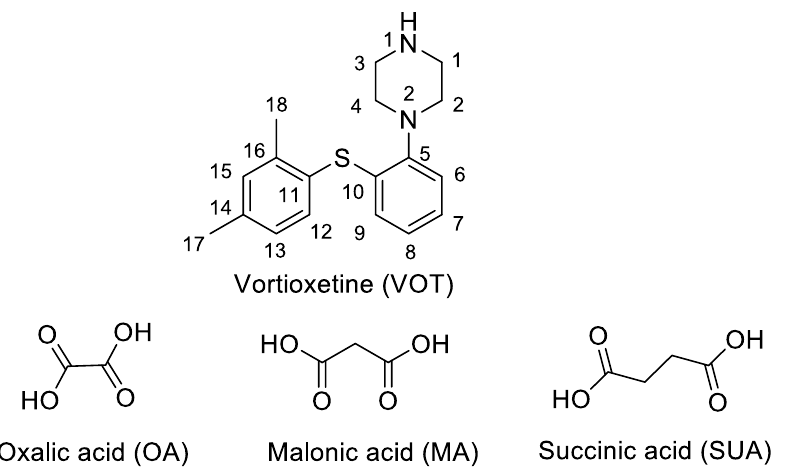
Figure 1. Chemical structures of VOT and coformers.